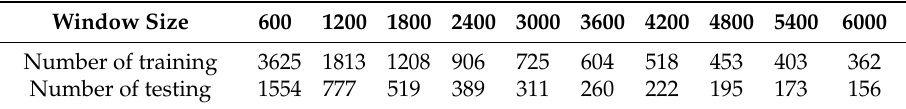
Table 4. Training and testing sample sizes of the experiments.